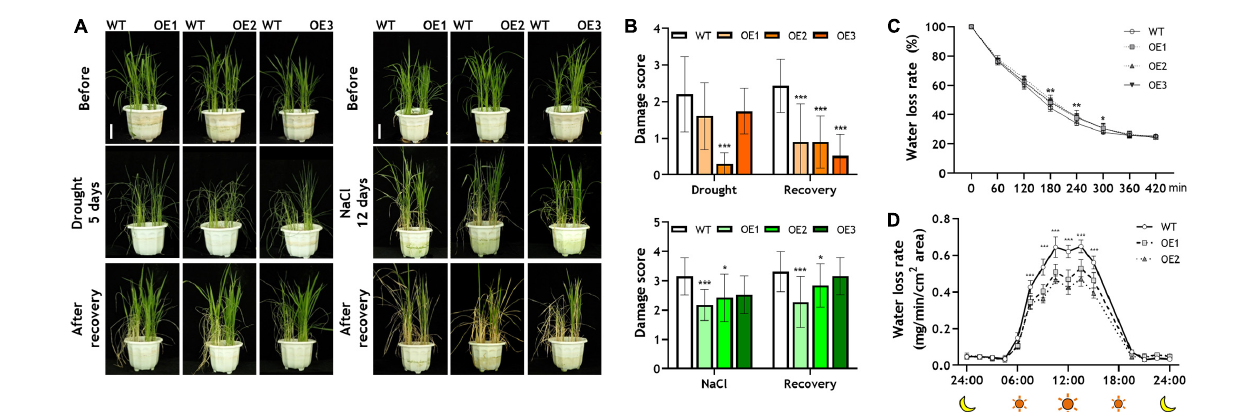
FIGURE 4 | Drought and salt responses of wild-type and OsRF1 -OE lines. (A) Drought and salt tolerance assay of transgenic rice. The WT and OsRF1 -OE lines, which were grown for 10 days in 1/2 MS medium, were transplanted in soil pots and grown for 12 days. For salt tolerance assay, 22-day-old WT and OsRF1 -OE rice seedlings were grown in soil pots with 200 mM NaCl for 12 days and then without NaCl for 7 days. For drought tolerance assay, 22-day-old seedlings were grown without water for 5 days and then with water for 7 days. Bar = 5 cm. (B) Damage rates of leaves after stress and recovery was measured and scored from 0 to 4. Data represent the mean ( ± SD) from three independent experiments with two biological replicates ( n = 10 for each line). (C) Water loss assay in detached leaves of wild-type and OsRF1 -OE lines. Water loss rate of detached leaves of 40-day-old WT and OsRF1 -OE transgenic rice was measured. Data represent mean ( ± SD) from three biological repeats with seven or eight replicates of each line. (D) Whole plant water loss rate of wild-type and OsRF1 -OE lines. Water loss rate was automatically measured from a soil pot planted with a single rice plant using DroughtSpotter under the none irrigating (NONE) mode. Data represent mean ( ± SD) from two independent experiments with five plants of each line. Two-way ANOVA and Fisher’s LSD test were performed by comparison with WT plants as controls. * P < 0.05; ** P < 0.01; *** P < 0.001.